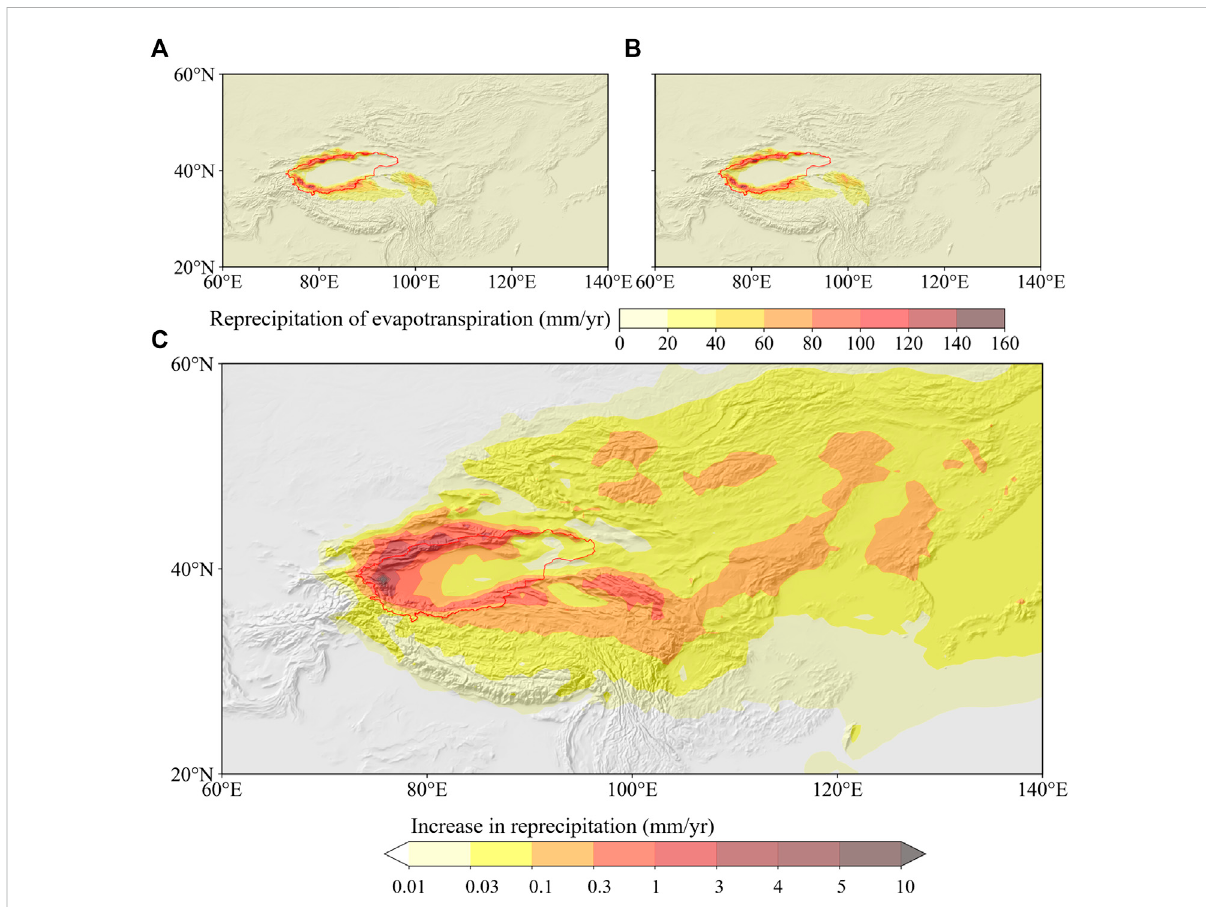
FIGURE 6 Spatial distribution ofreprecipitationintheTarimBasin of (A) thebaseline scenarioand (B) ScenarioI,and (C) thedifference between ScenarioI and the baseline scenario.